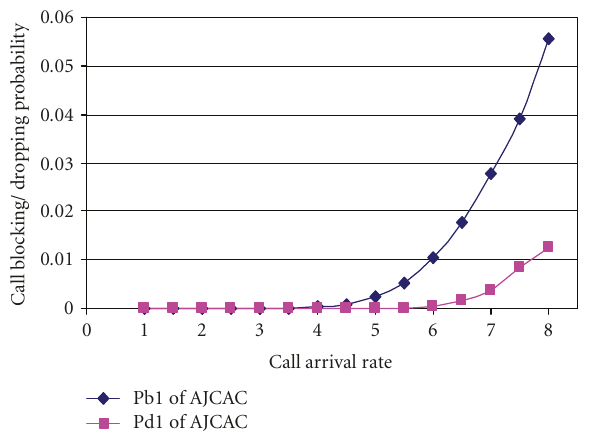
Figure 7: E ff ect of varying the call arrival rate on the new call blocking probability and hando ff call dropping probability of class- 1 calls.